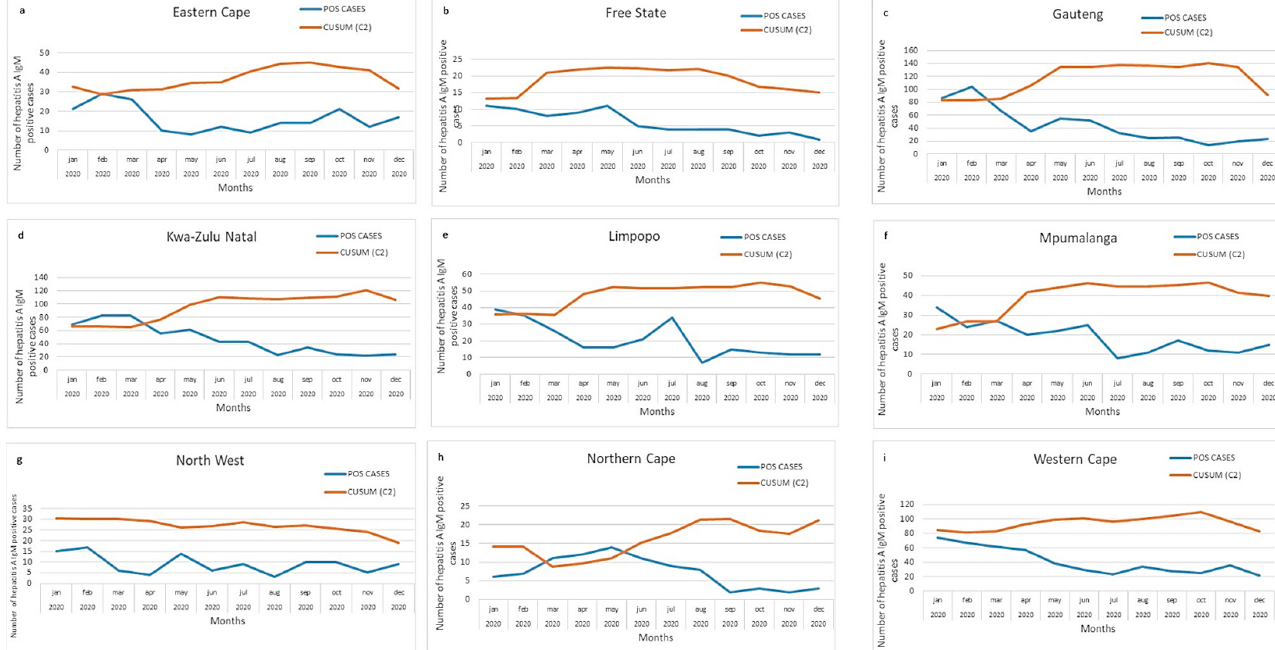
Viruses 2021 , 13 , x FOR PEER REVIEW Figure 3. ( a – i ) Acute hepatitis A cases by province in South Africa, 2020. Number of acute hepatitis A cases in 2020 (orange bars) shown in comparison with mean and two (black line) or three (red line) standard deviations of data from 2017 to 2019.